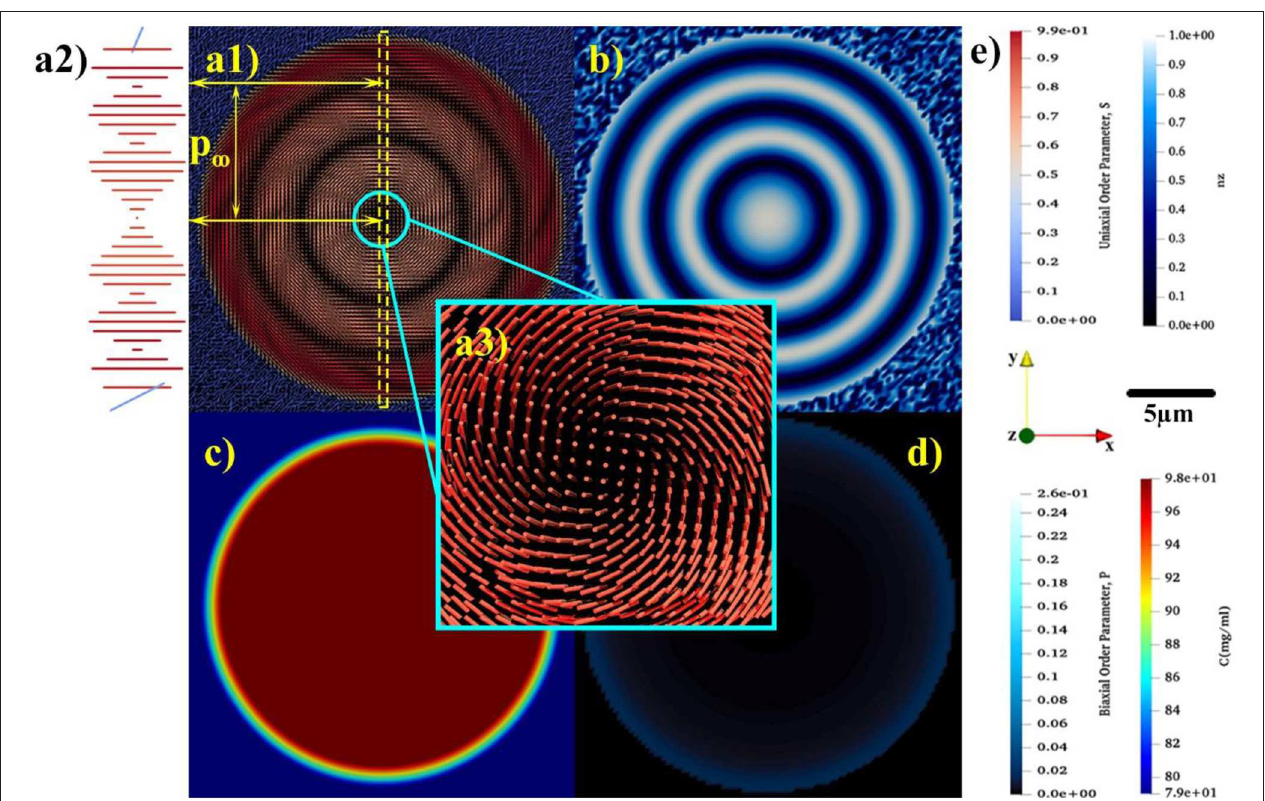
FIGURE 4 | The equilibrium spatial distributions of (a1) uniaxial order parameter, S, and the relaxed uniaxial director, n , (b) z component of uniaxial director, (c) concentration, and (d) biaxial order parameter, P. (a2) showing the magnified rotation of tropocollagen placed in the yellow dash-line box. (a3) indicating the non-singular escaped λ + 1 disclination emerges at the center of tactoid. (e) Representing the color bars for S, n z , P, and C, the used coordination of system and length-scale bar.